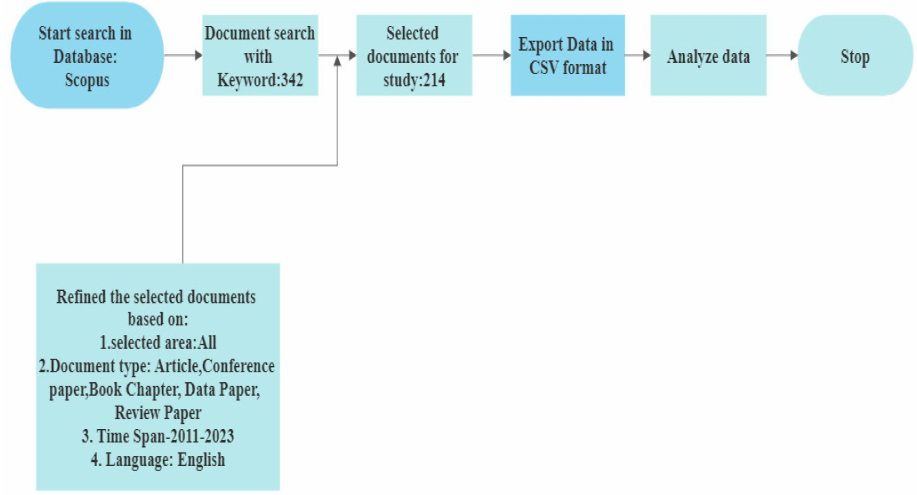
Figure 9. Procedure for Selection of Documents from Scopus